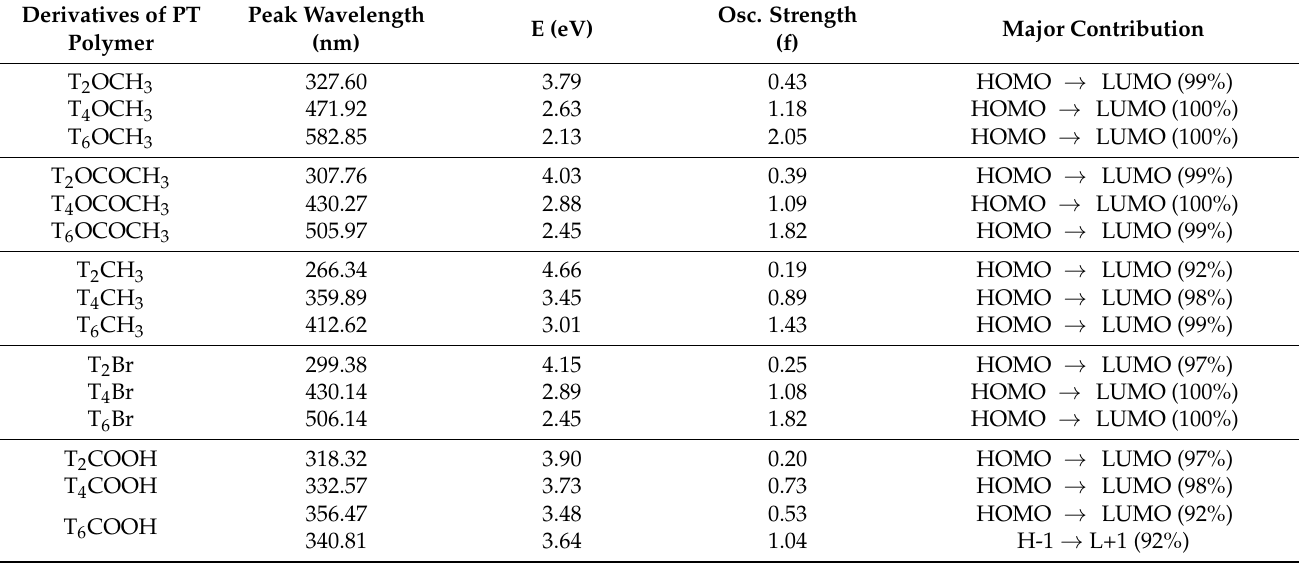
Table 5. Wavelengths of highest peak of absorption spectra of derivatives of T2, T4, and T6. Derivatives of PT